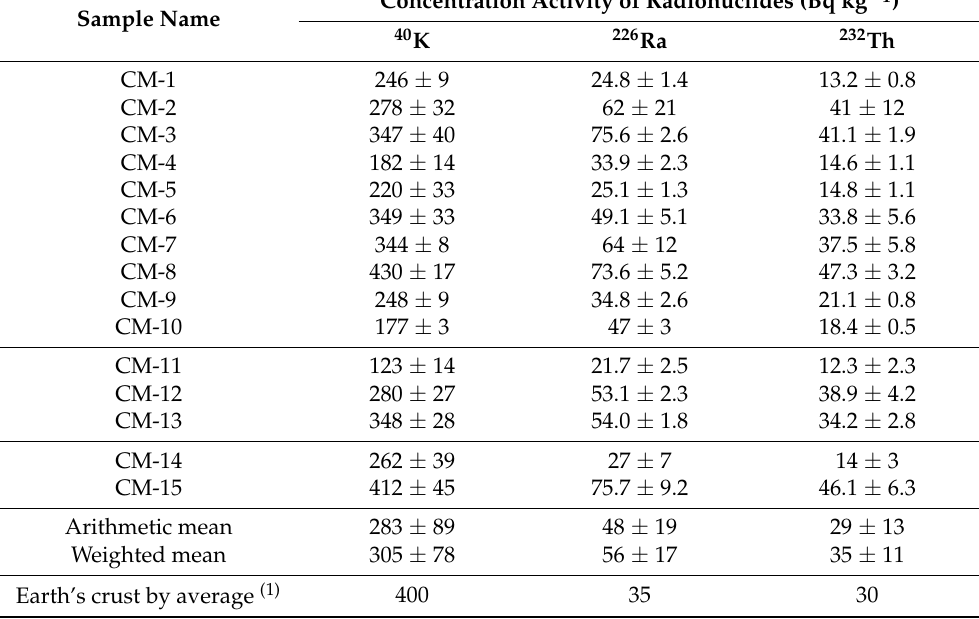
Table 3. Concentrations of radionuclides 40 K, 232 Th and 40 K in samples of cement with desig- nated uncertainties. Presented values are weighted means of 4–6 quantities obtained via measuring with MAZAR or HPGe devices (except for CM-14 and CM-15, see the text). Each individual un- certainty was estimated via the spectrometer software, while the values appearing beneath are weighted